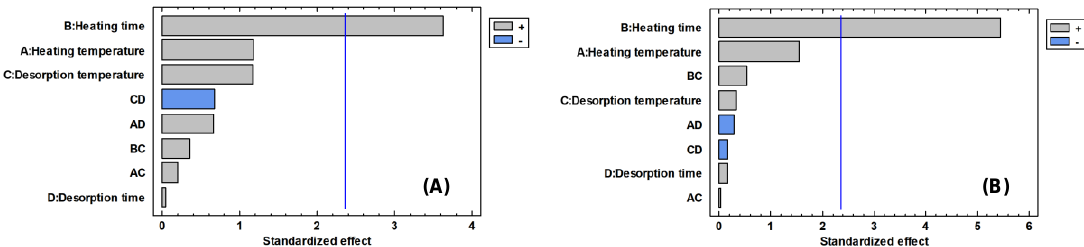
Figure 1. Pareto chart of main effects in the 2 4 factorial design for number of chromatographic peaks ( A ) and total area ( B ).